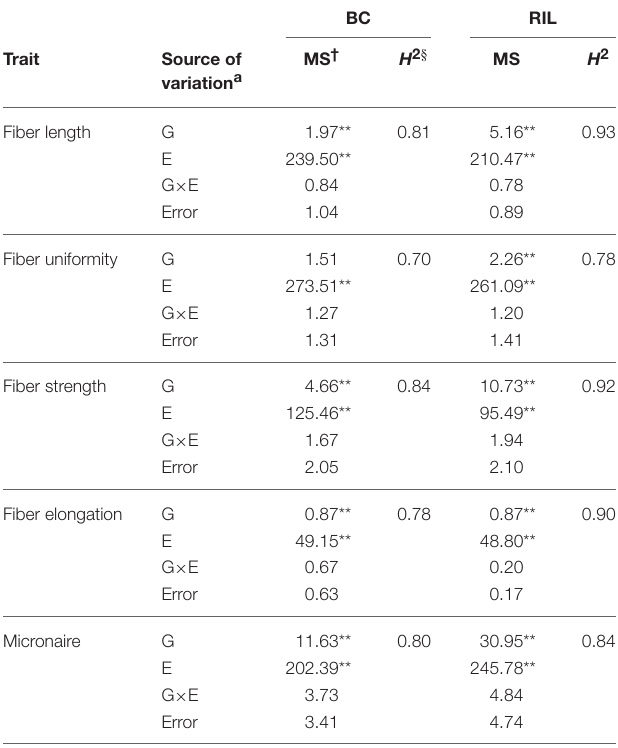
strength on average. The genetic effects of the QTLs from RI lines TABLE 2 | ANOVA analysis and heritability for fiber quality traits in BC and RIL populations. were stronger than that from the corresponding BCF 1 s, whatever QTLs were detected on Chr 5 or on Chr 21. It indicated that BC RIL additive QTLs played more important role in improving fiber Trait length and fiber